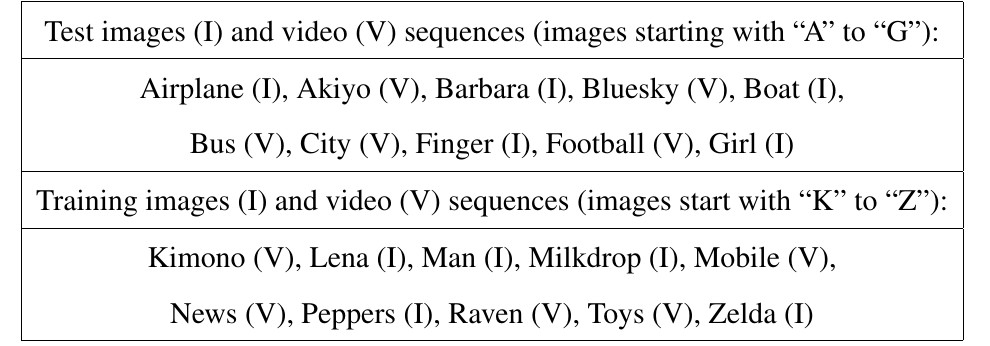
Table 1. Test and training sets classified by alphabetical